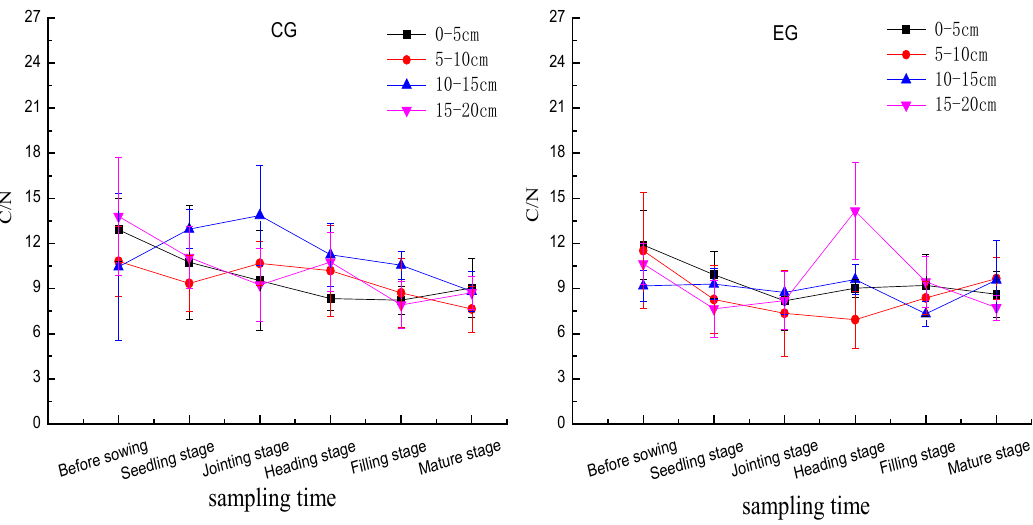
Figure 4: Temporal variation of C/N ratio in the control group (CG) and the experimental group (EG) soils subject to poultry wastewater irrigation.